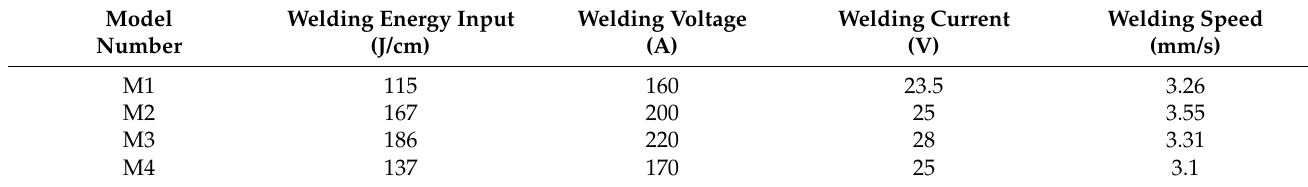
Table 2. Mechanical properties and chemical composition of L907A steel. Table 3. Welding process parameters of the stiffened plate